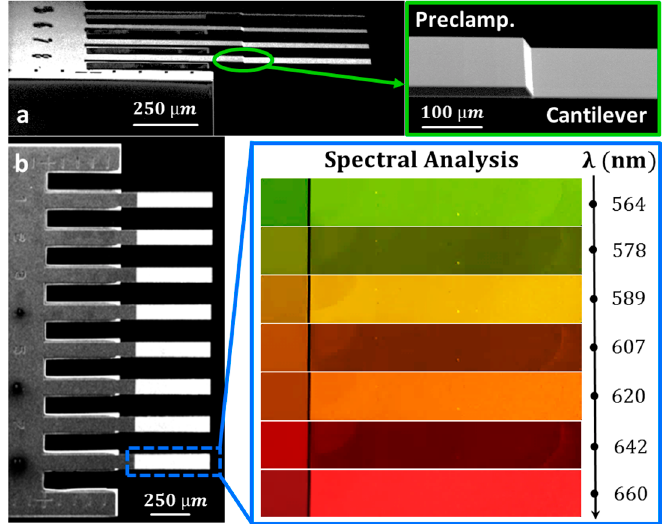
Figure 2. ( a ) SEM image in perspective view of four cantilevers; the top right inset (green box) is a zoomed SEM image near the cantilever clamping that evidences the frontier between the 6 µm thick pre-clamping structure fixed to the chip and the 1 µm thick cantilever; ( b ) SEM image of an entire array; the right inset (blue box) is a sequence of different bright-field images of a microcantilever obtained at different illumination wavelengths.